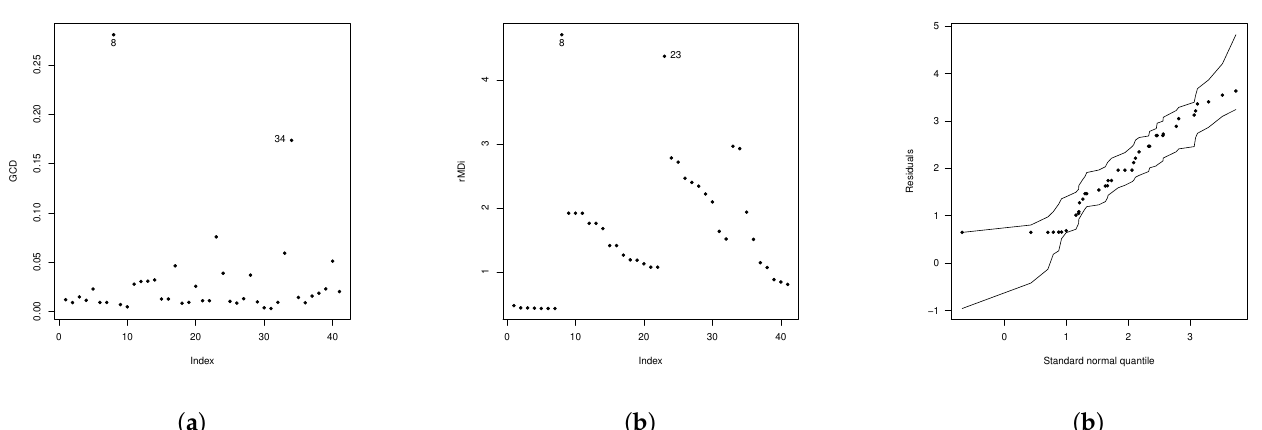
Figure 7. Influence measures for the EGSHN model ( a ) Cook’s distance, ( b ) rMT i , ( c ) envelope picture of EGSHN model.